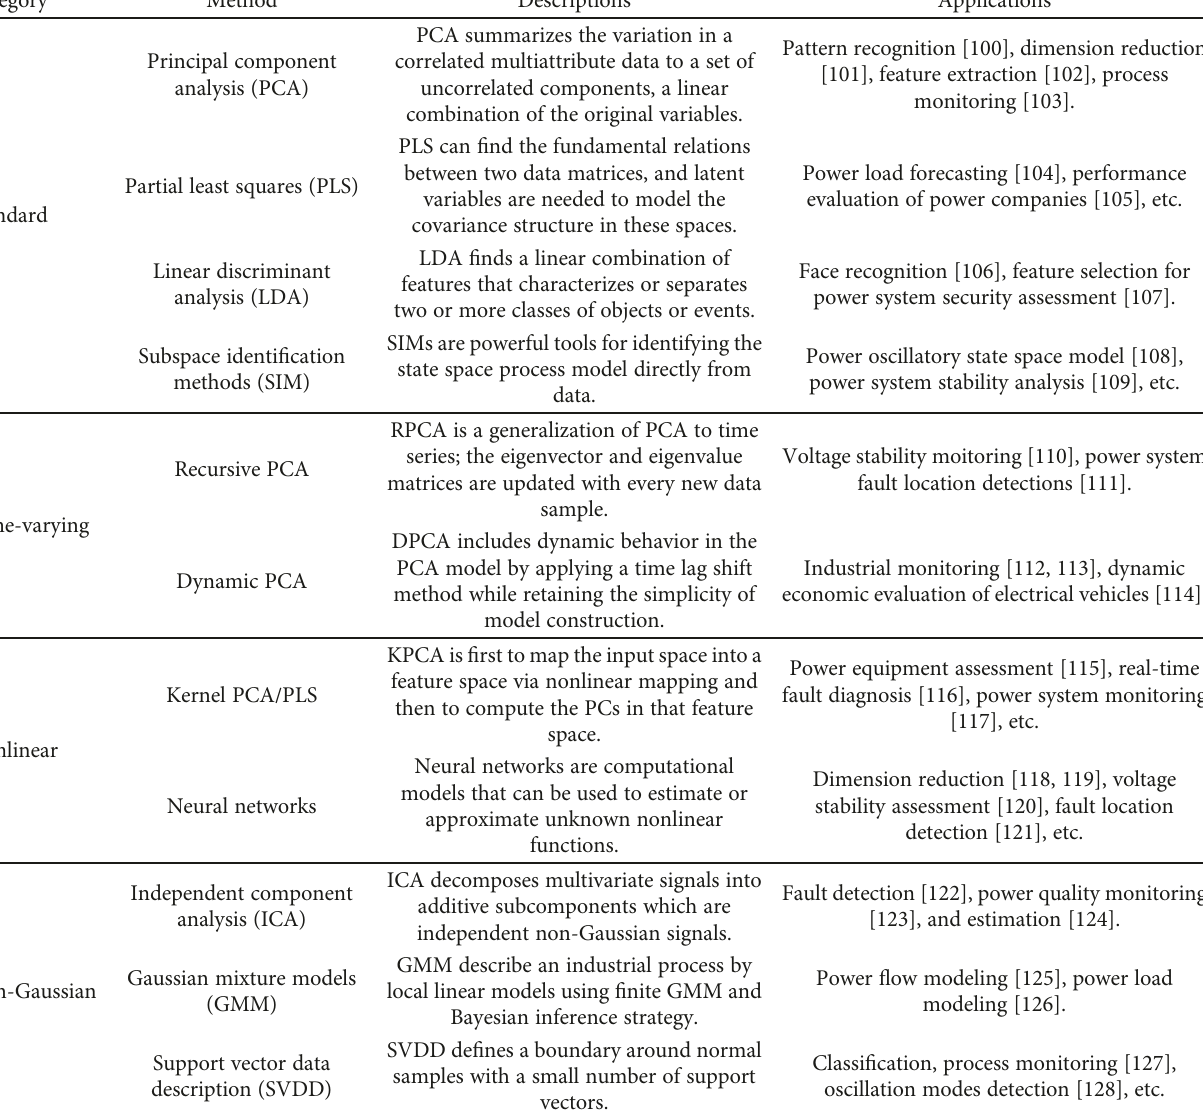
Table 3: An overview of state-of-the-art intelligent processing methods.